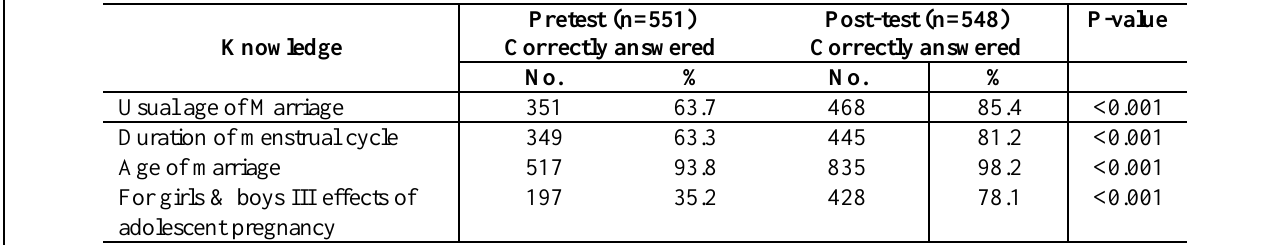
Table II : Knowledge about Menstruation, Menarche, Age at marriage